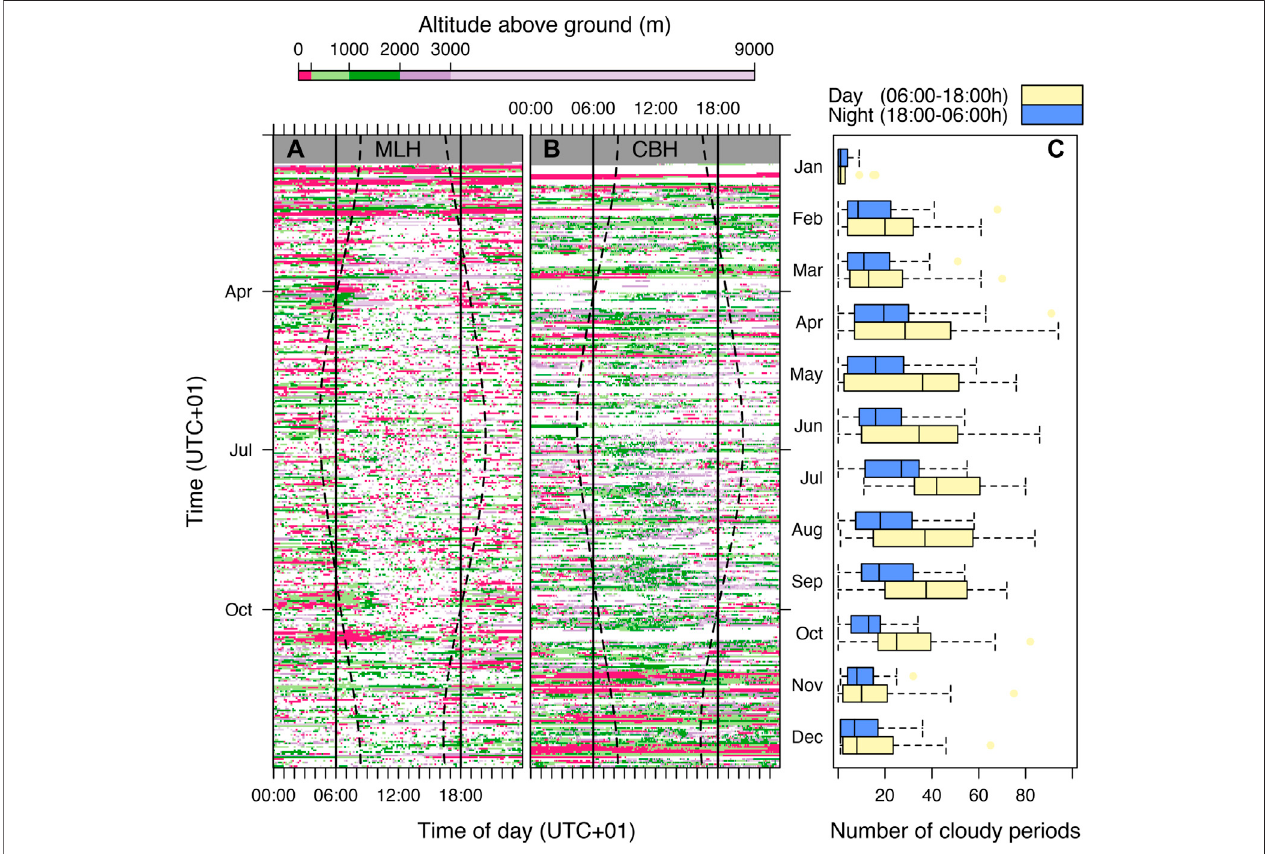
FIGURE 4 | The (A) mixing layer height (MLH), (B) the cloud base height (CBH) and (C) a the number of cloudy periods during the day and night per month are shown for Stuttgart City Centre. Day time was de fi ned as the period between 06:00 UTC to 18:00 UTC and sunset and sunrise times are shown in the left panels as dashed